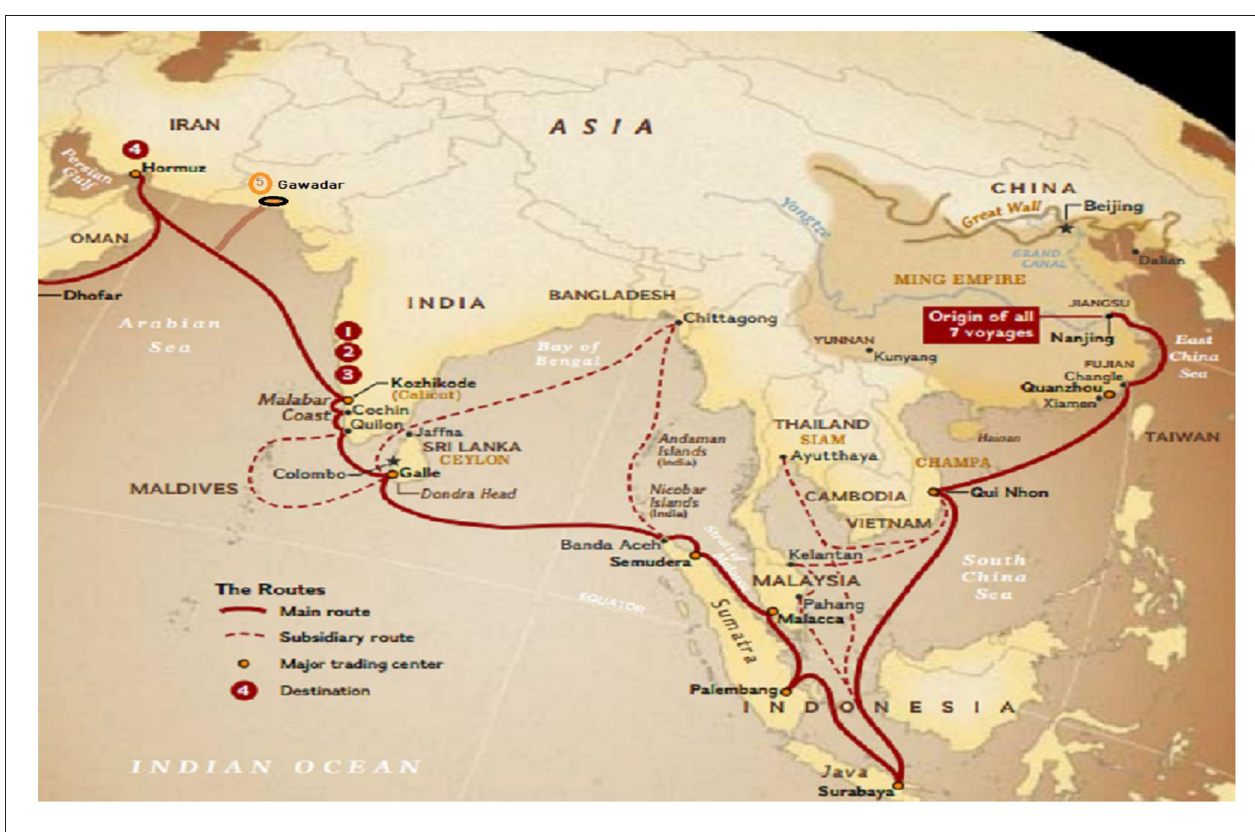
FIGURE 10 | 21st Maritime in South Asia [re-developed, Map (68)].